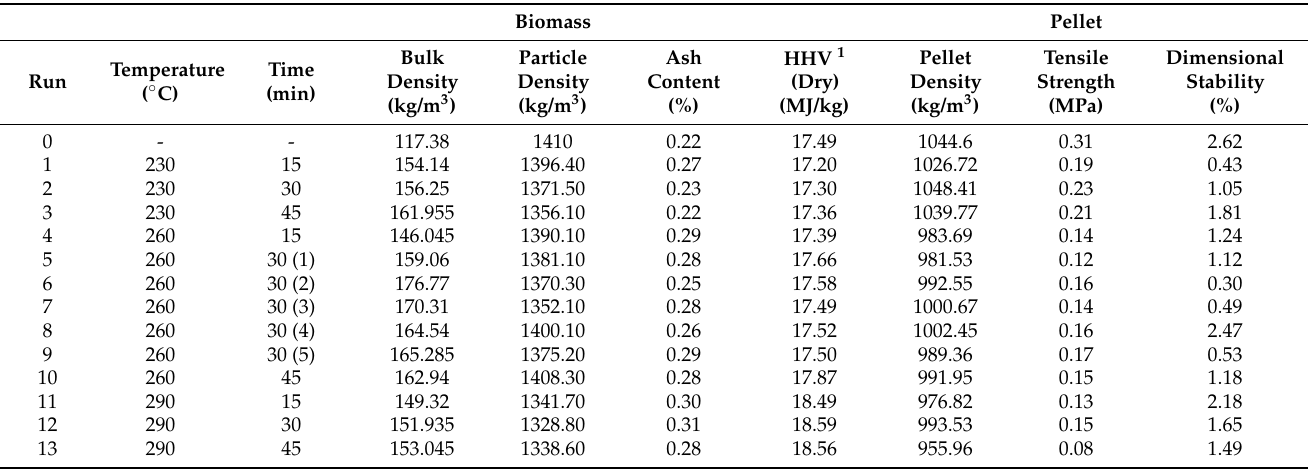
Table 2. Mean values of physical and mechanical properties of torrefied vs. non-treated sawdust and resultant